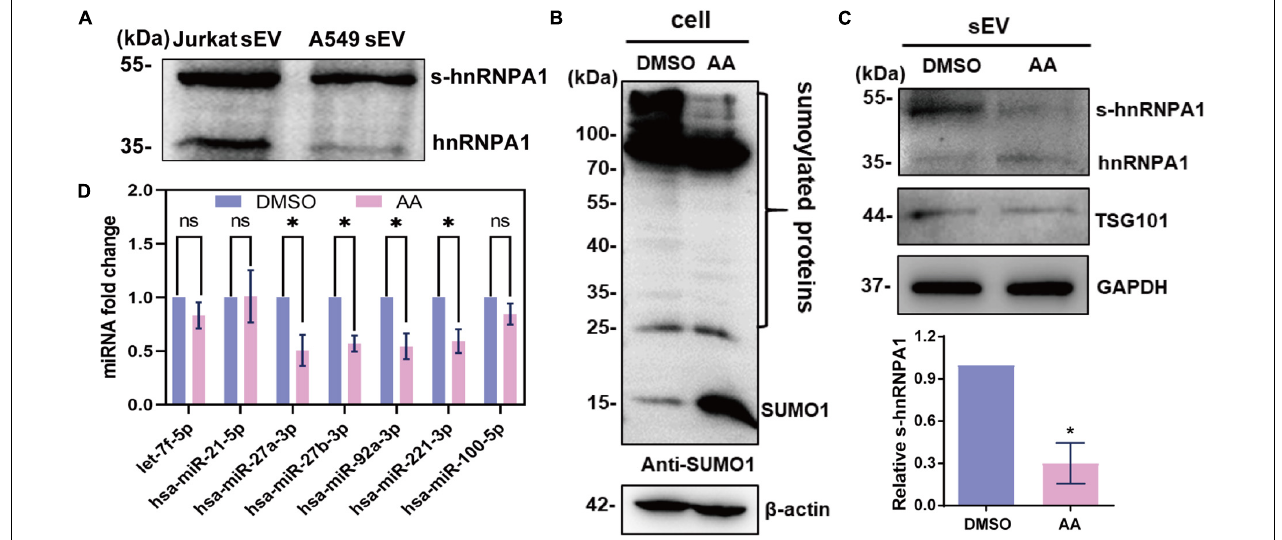
FIGURE 4 | SUMOylated hnRNPA1 controls sEV-miRNA loading. (A) Western blotting showing the expression of hnRNPA1 including SUMOylated hnRNPA1 in sEVs derived from Jurkat and A549 cells. (B) The protein SUMOylation level in cells treated with DMSO and AA. Anti-SUMO1 small molecule antibody was used for western blotting. (C) Corresponding SUMOylated hnRNPA1 in sEVs derived from cells treated with DMSO and AA (top panel). Statistical analysis showing the ratio of SUMOylated hnRNPA1 and hnRNPA1 in three independent experiments (bottom panel). (D) Expression levels of selected sEV-miRNAs derived from DMSO- and AA-treated cells. The significant differences are reported for four independent experiments (ns, no significance; ∗ p < 0.05, two-tailed t -test). hnRNPA1, heterogeneous nuclear ribonucleoprotein A1; sEV-miRNA, microRNA in small extracellular vesicle; DMSO, dimethyl sulfoxide; AA, anacardic